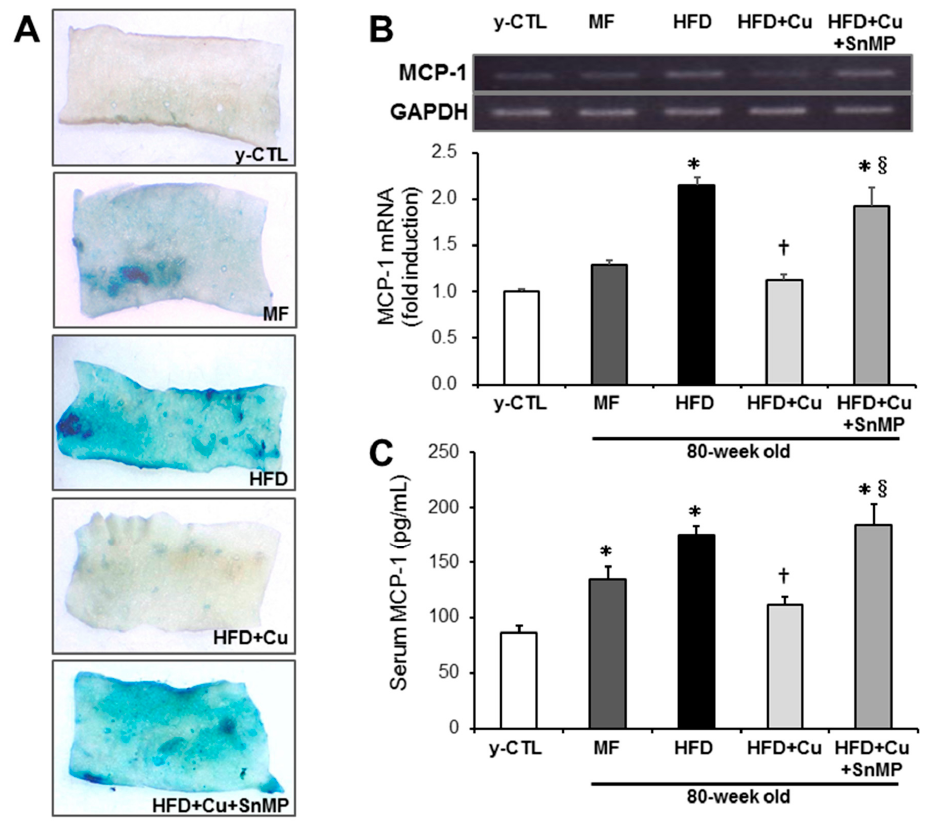
Figure 5. Effect of curcumin on SA β -gal activity and MCP-1 expression in mice. MF (standard feed), High-fat diet (HFD), 0.1% curcumin-mixed HFD (HFD + Cu), or 0.1% curcumin-mixed HFD plus SnMP (HFD + Cu + SnMP) was fed to mice for 72 weeks. ( A ) An increase in senescent cells in the thoracic aorta was analyzed by SA β -gal staining. ( B ) Expression of MCP-1 mRNA in the aorta was assessed by real-time RT-PCR. The expression level was standardized by GAPDH. ( C ) MCP-1 blood levels were measured by an MCP-1 ELISA kit. Data were presented in mean ± standard error for each group ( n = 5). * P < 0.05 vs. y-CTL, † P < 0.05 vs. HFD, § P < 0.05 vs. HFD + Cu. SnMP, Stannous Mesoporphyrin; SA β -gal, senescence-associated β -galactosidase; y-CTL, 8 weeks old